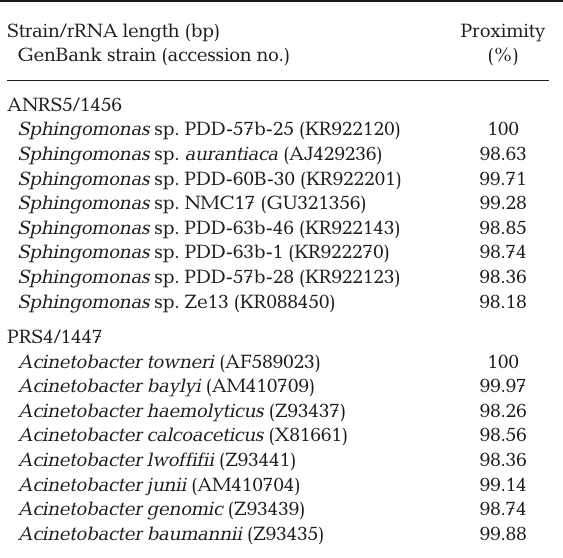
Table 4. Genomic proximities between the isolated and GenBank strains. ANRS: ammonia nitrogen removal strain; PRS: phosphate removal strain